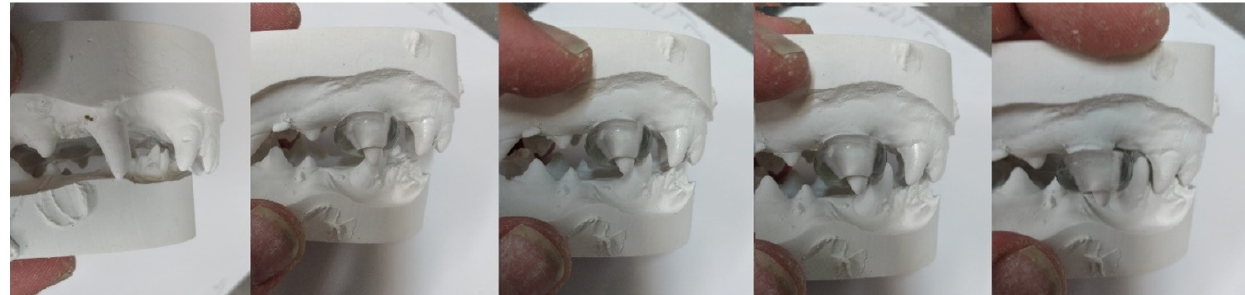
Figure 16. The sequence of the forward movement of the lower jaw and the canine guidance.